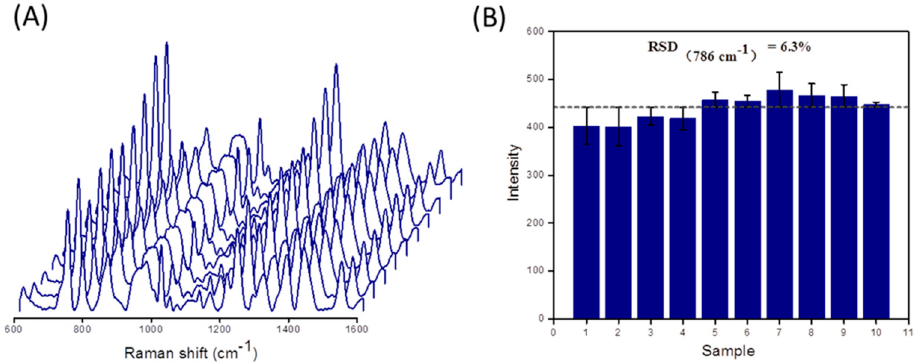
Figure 8. ( A ) Ten random SERS spectra of flumetsulam absorbed on the two-step modified concentrated AuNPs substrate under the same conditions; ( B ) The histogram of Raman intensity for each random SERS measurement (the error bar indicates the signal derivation of ten random SERS measurements from different samples).